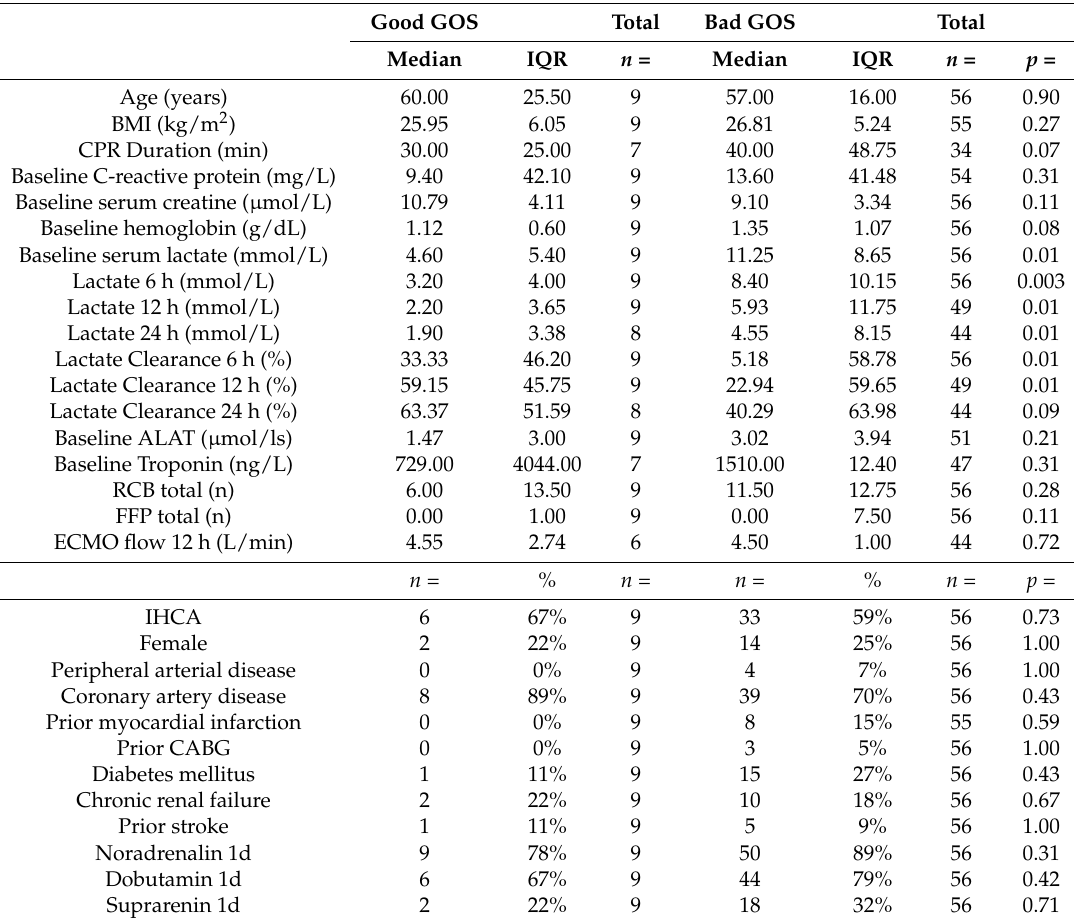
Table 2. Baseline characteristics of the study